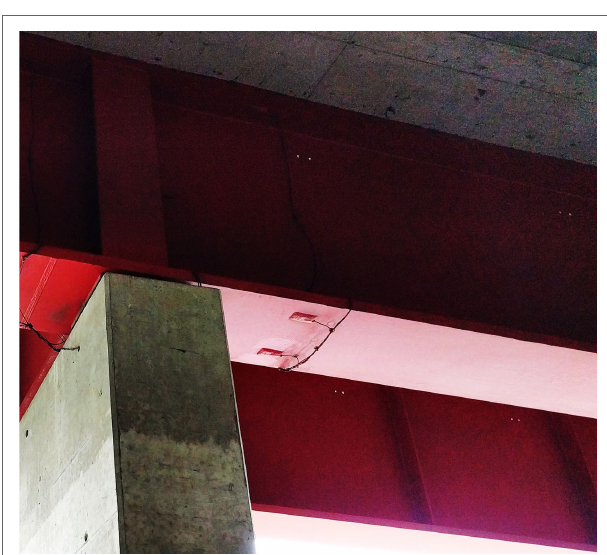
FIGURE 3 | Sensors B1 and B3 on the Venoge bridge (Credit: IMAC,